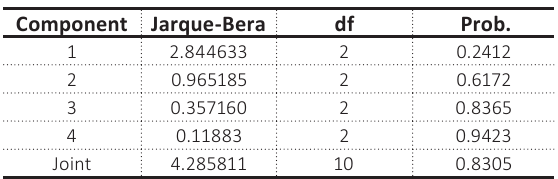
Table 8. VAR residual normality tests